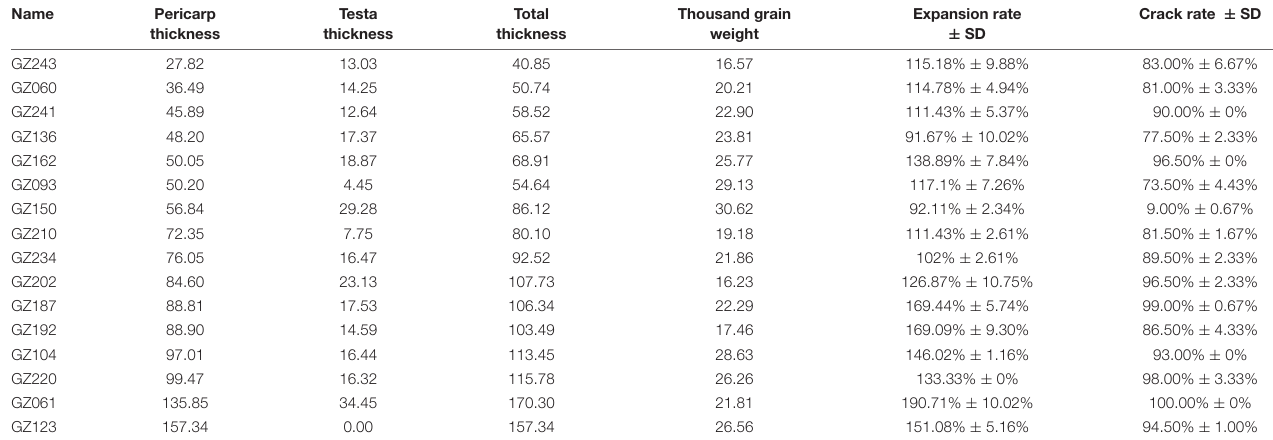
TABLE 1 | Results of cooking experiment for glutinous